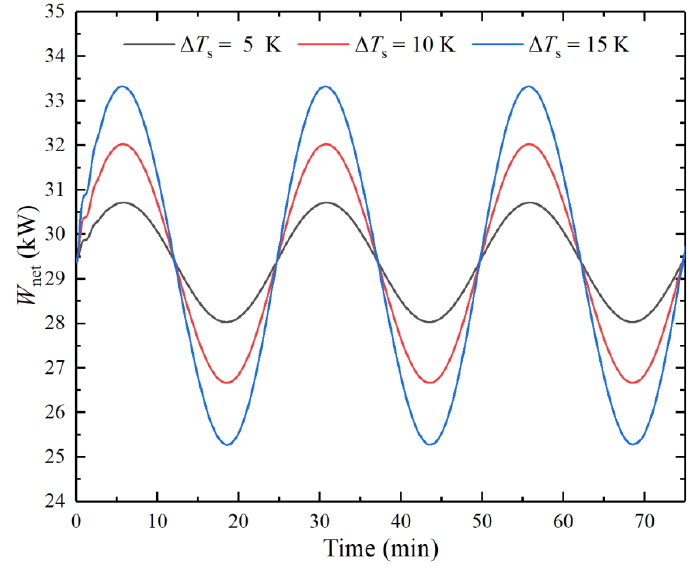
Figure 8. Net power output under different amplitudes.